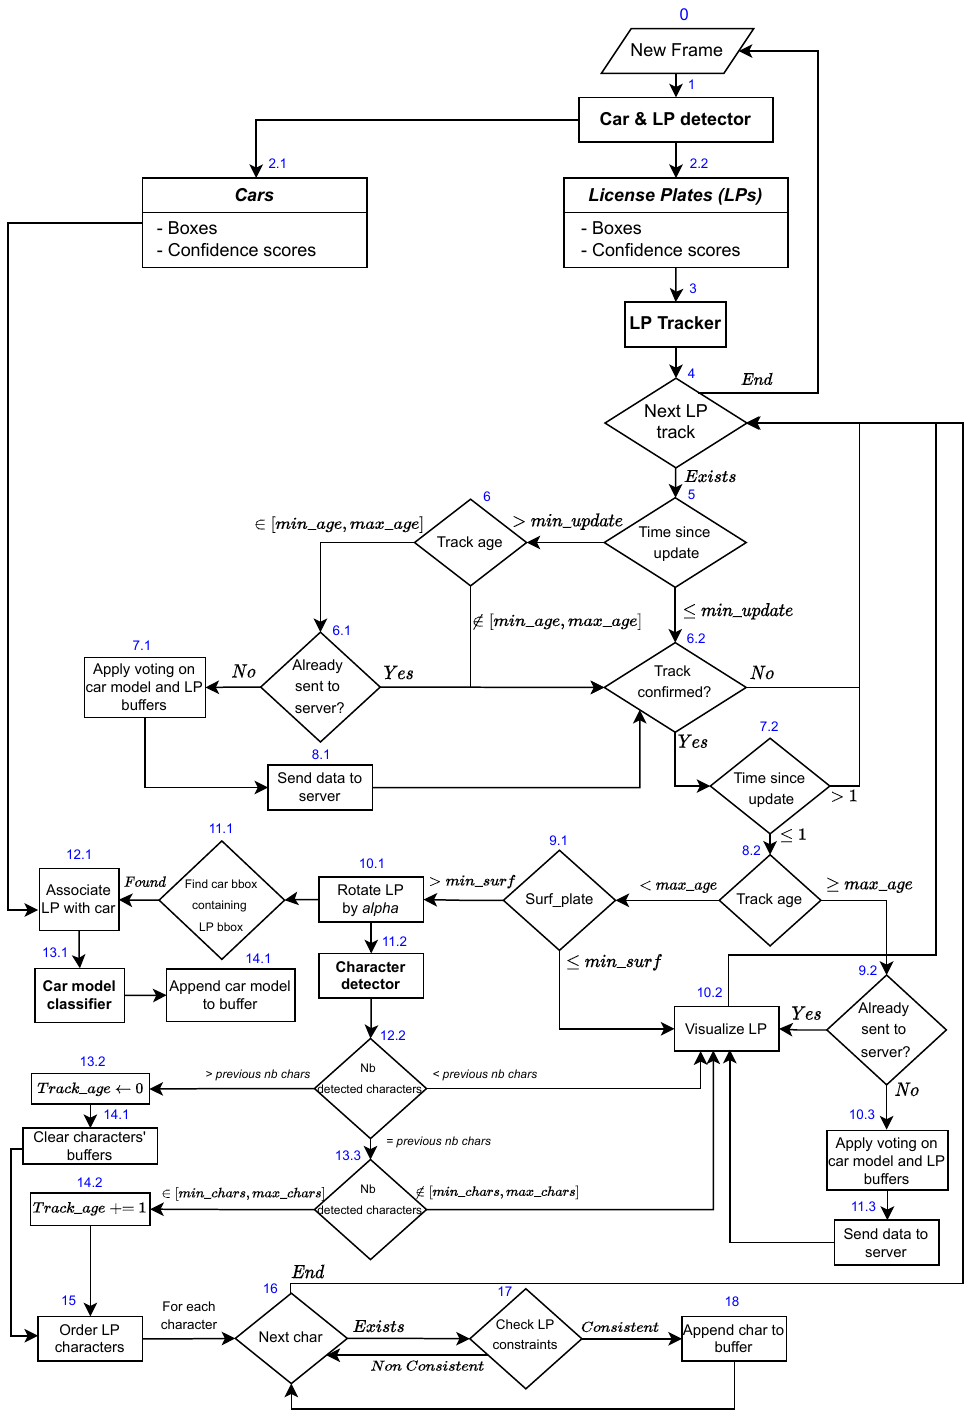
Figure 11. Complete process of the car model classification and license plate recognition. Step numbers are shown in